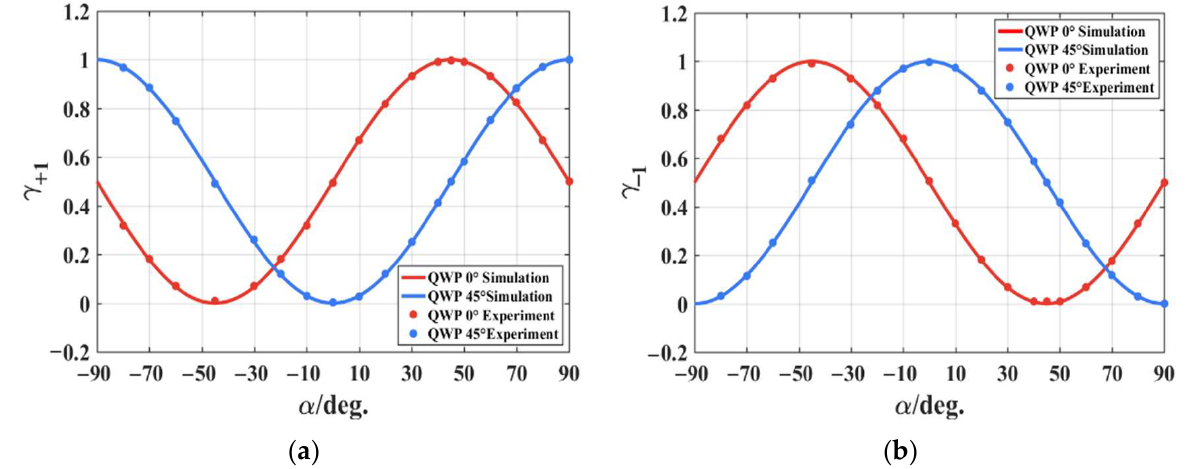
Figure 6. Plots of ( a ) γ +1 and ( b ) γ −1 as a function of the direction α of linearly polarized incidence. the theoretical values are represented by solid curves, while the experimental measurements are represented by dots mark. Table 1. Experimental data of linear polarization detection. Direction of